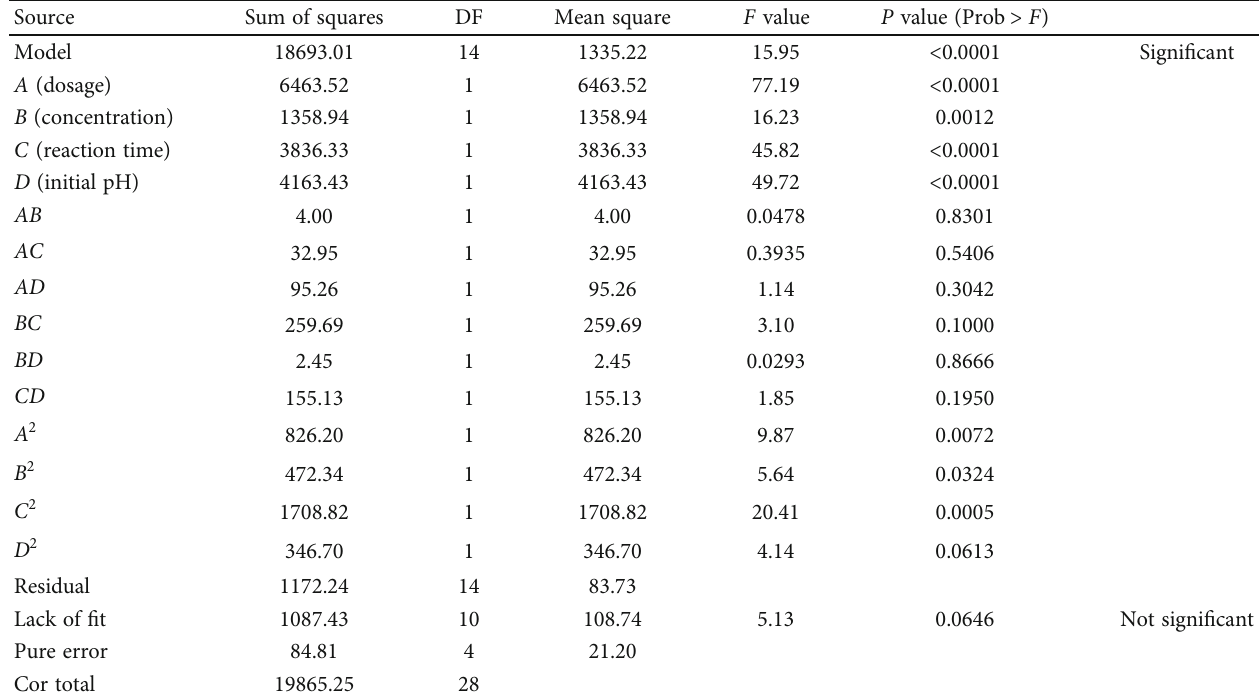
Table 3: ANOVA of the response surface for the quadratic